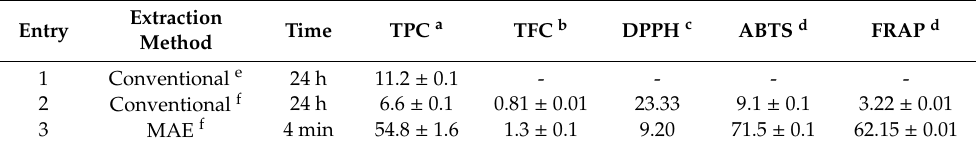
Table 2. Total phenolic, flavonoid contents, and antioxidant activity of bamboo shoot extracts obtained under two di ff erent extraction